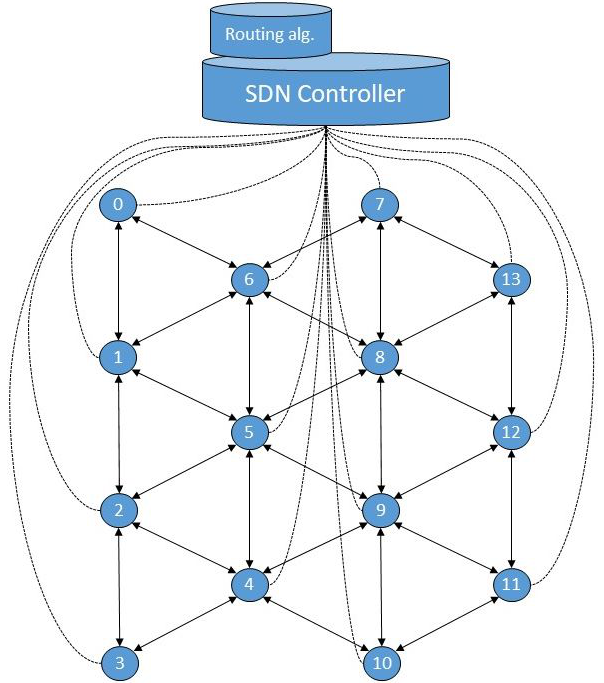
Figure 8. Topology of the experimental